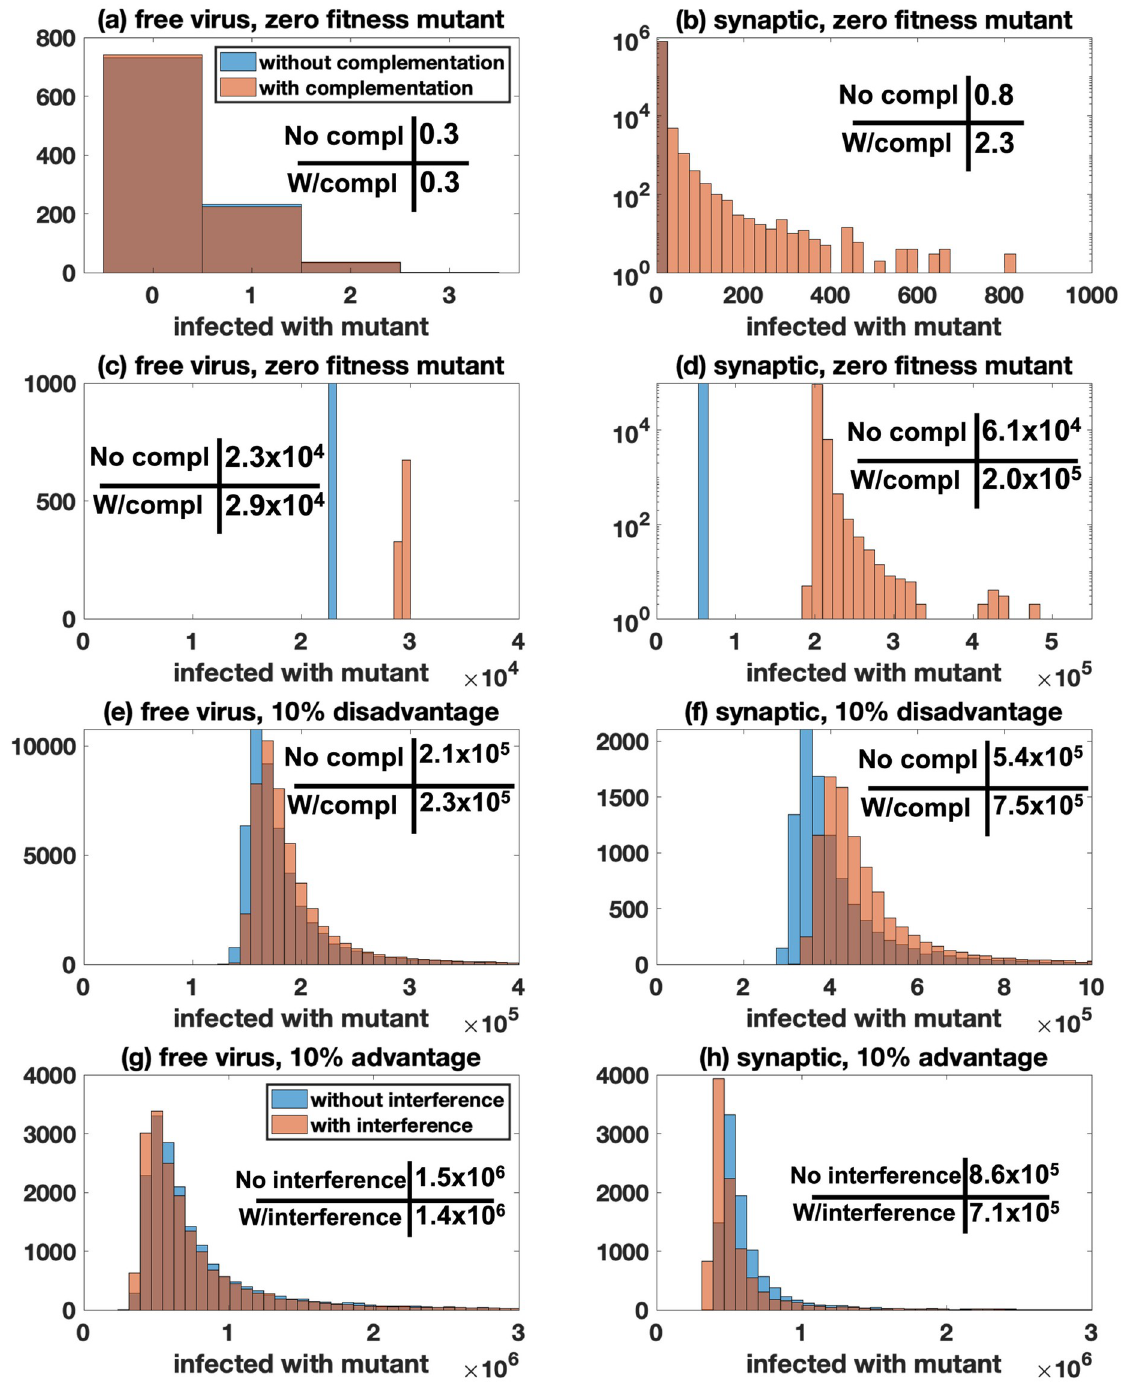
Fig 4. Mutant evolution under different scenarios with 100% free virus transmission (left panels: β = 3.6 × 10 − 9 , γ = 0, N = 11) or 100% synaptic transmission (right panels: β = 0, γ = 3.6 × 10 − 9 , S = 3, N = 25). Panels A and B record the number of cells infected with the mutant at 10 4 infected cells, for all other panels it is 5 × 10 8 infected cells. For all panels, the blue bars represents simulations without complementation/interference and the red bars represents simulations with complementation/interference. The mean values are presented in each panel. For panels B-H, p < 10 − 6 by the Kolmogorov-Smirnov test. A-D Zero fitness mutant ( F mutant = 0). E-F Disadvantageous mutant ( F mutant = 0.81). G-H Advantageous mutant ( F mutant = 0.99). For all simulations, we fix M ¼ 50 ; F parameters are as in Fig 1 ( μ = 3 × 10 − 5 , λ = 1.59 × 10 7 , a = 0.45, and d = 0.016).